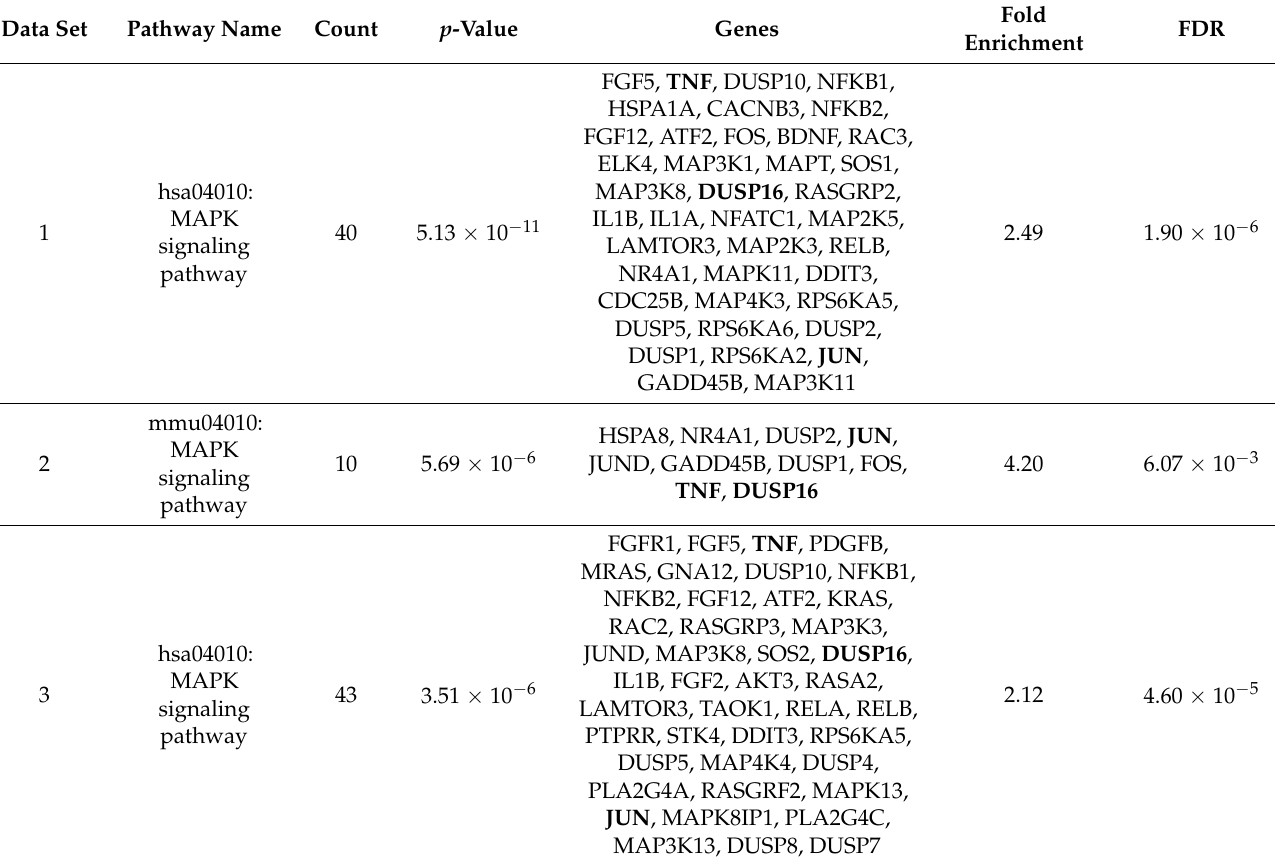
Table 3. MAPK signaling pathways identified from up-regulated genes from three microarray data sets. Common genes identified from these three data sets are